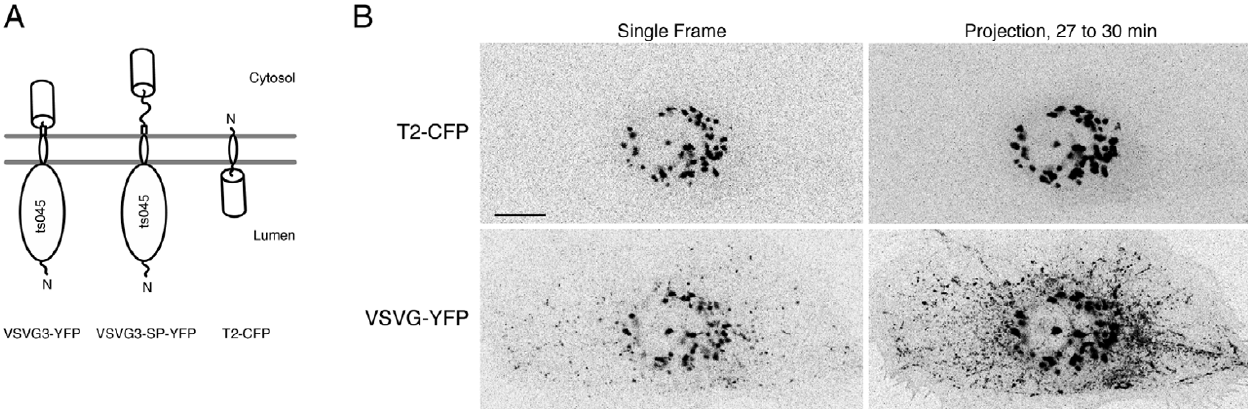
Figure 1 Golgi elements remain stable in shape, size, and position during a high flux of cargo exit A. Schematic of fluores- cent transmembrane proteins used in this study, showing relative orientation, approximate location of protein domains, and placement of the fluorescent protein tag (cylinder). B. Golgi dynamics during a high flux of cargo exit. VSVG3-YFP was accumu- lated overnight in the ER of transiently transfected PtK 2 cells and released synchronously into the secretory pathway by shifting to 32 ° C. Imaging was initiated after 27 minutes at 32 ° C, during the peak period of TC exit from the Golgi. The Golgi in PtK cells comprises scattered, separate elements near the MTOC. Comparison of single frames from the beginning of the movie (top panels) with projections over a 3 minute period (bottom panels) shows Golgi elements containing T2-CFP remain stable as VSVG3-YFP cargo exits the Golgi in TCs, which track outwards to the cell periphery. This figure corresponds the movies in Additional Fileset 1. Bar: 10 µ